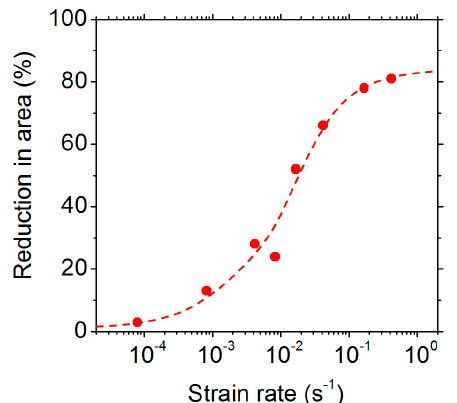
Figure 5. The reduction in area observed after tensile testing at 850 ◦ C of the 9 ppm S material at Figure 5 : The reduction in area observed after tensile testing at 850 °C of the 9 ppm S material at di ff erent strain rates. A pre-heating step at 850 ◦ C was conducted so that the total time spent at 850 ◦ C different strain rates. A pre ‐ heating step at 850 °C was conducted so that the total time spent at 850 for all the specimens was 40 min. °C for all the specimens was 40 minutes.